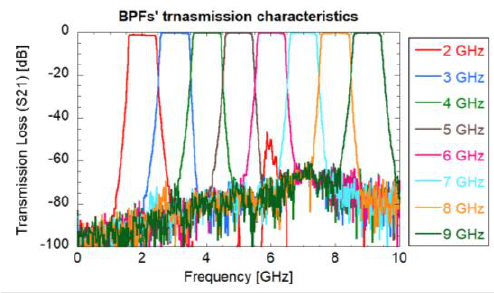
Fig. 9. Frequency response of each bandpass filter.